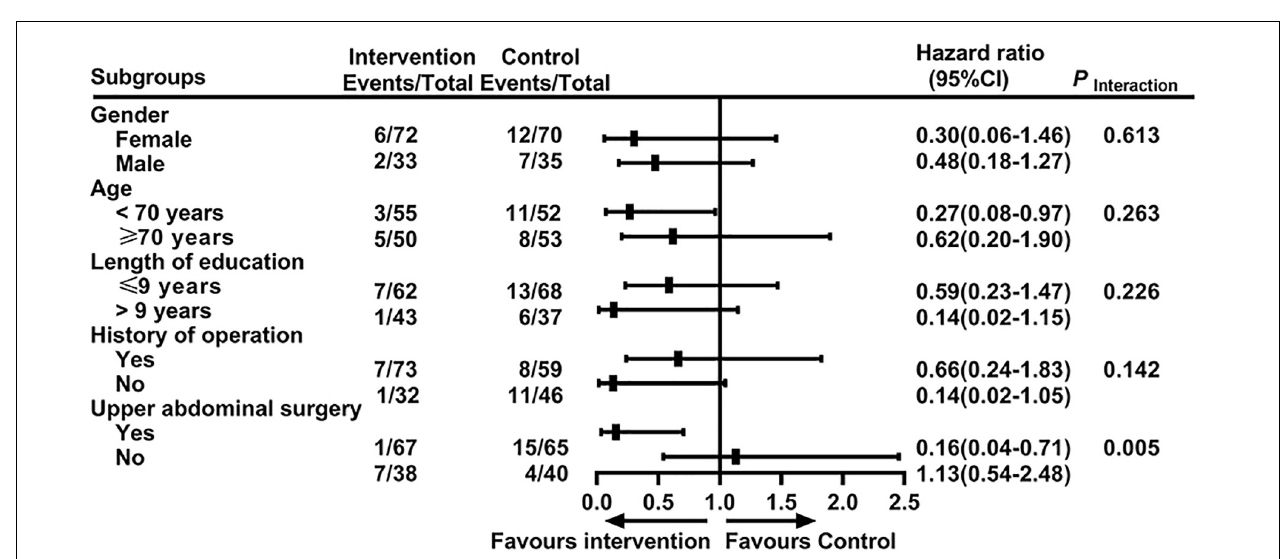
FIGURE 2 | Kaplan–Meier curve showing the probability of a patient being delirium-free within seven postoperative days.